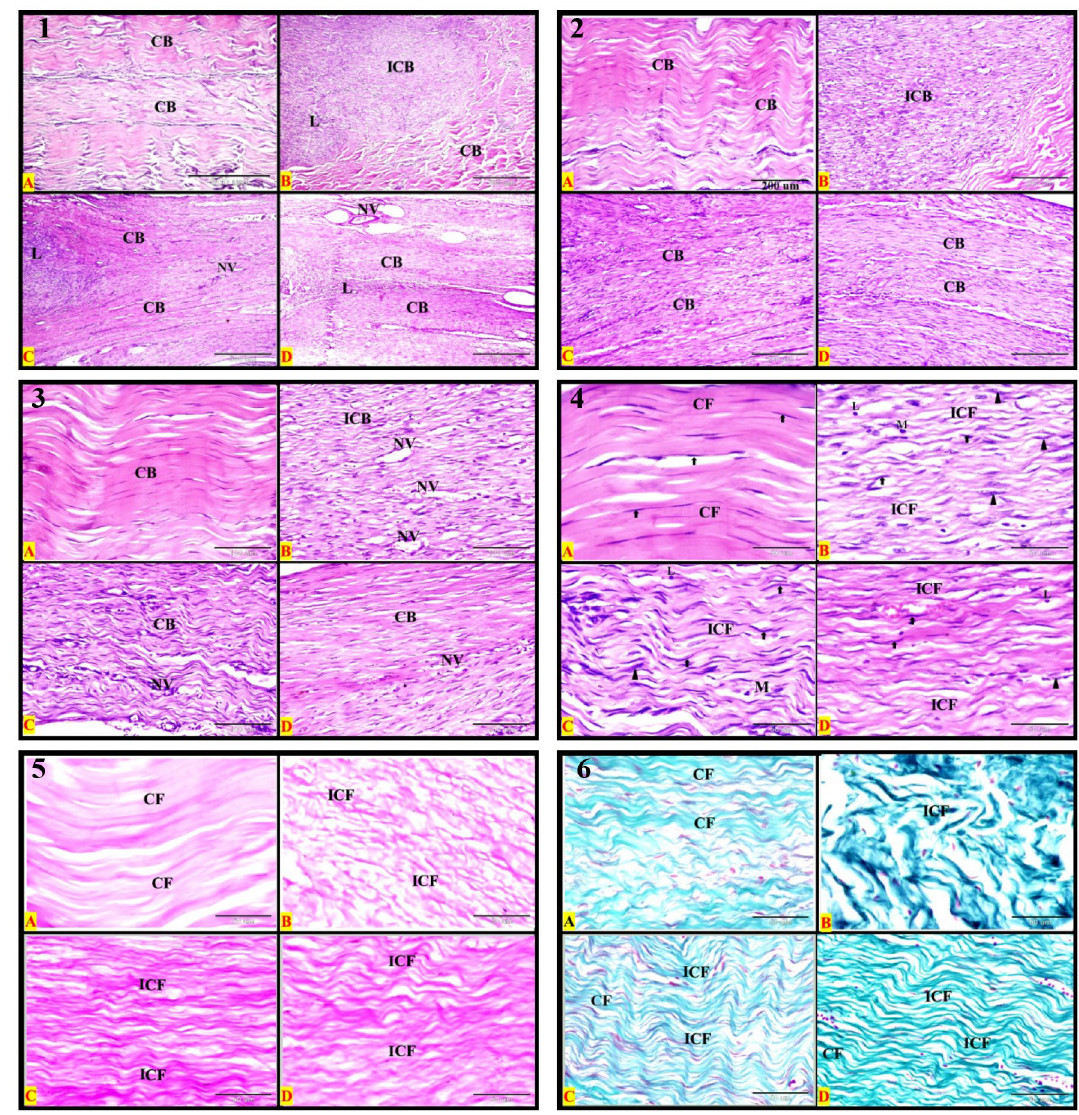
Figure 4. Photomicrograph of longitudinal section from the SDFT at 2 month post-injury. ( A ) Negative control, ( B ) positive control, ( C ) PRF treated, and ( D ) AgNPs treated. plates (1–4): Haematoxylin and eosin stains, Plate (5): PAS & Haematoxylin and plate (6): Crossmon’s trichrome stain. CB regular collagen bundles, ICB irregular bundles, H hemorrhage, L inflammatory leucocytic infiltration, NV neovascularization (new blood vessels formation). All details of figures are displayed in Table 2. Plates 1, 2: Bars = 500 μm (40×); Plates 3, 4, 6: Bars = 50 μm (400×); Plate 5: Bars = 100 μm